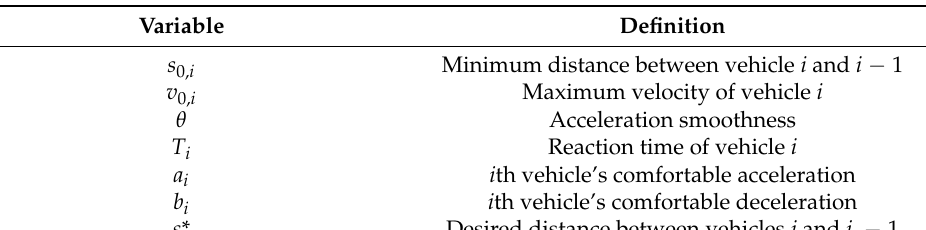
Figure 9. Reference diagram for defined variables. Table 1. IDM parameters.